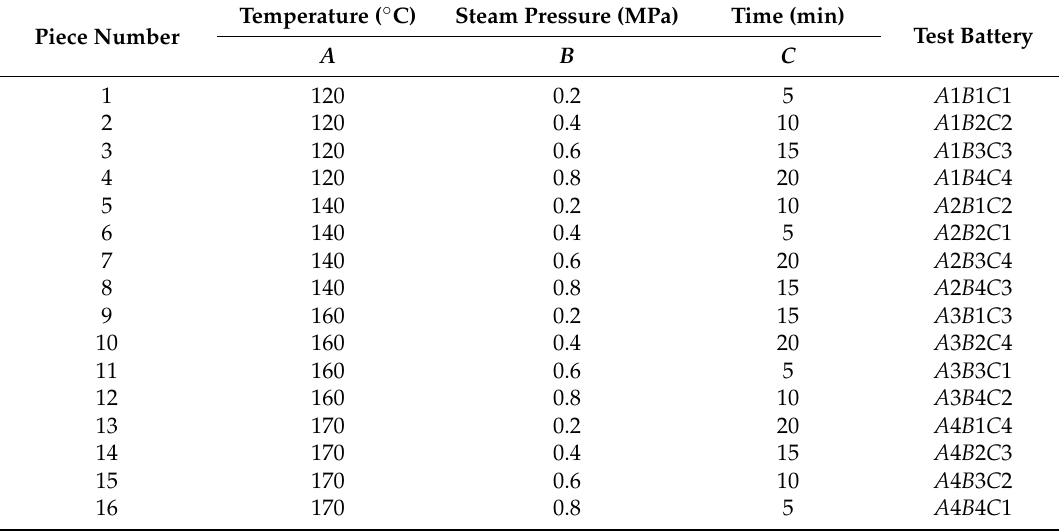
Table 2. Orthogonal experimental design for the L16 (45) orthogonal